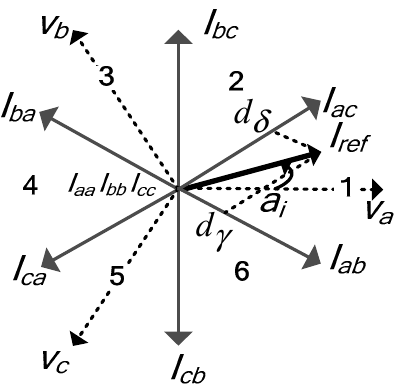
Figure 4. The space vector diagram of the rectifier stage.